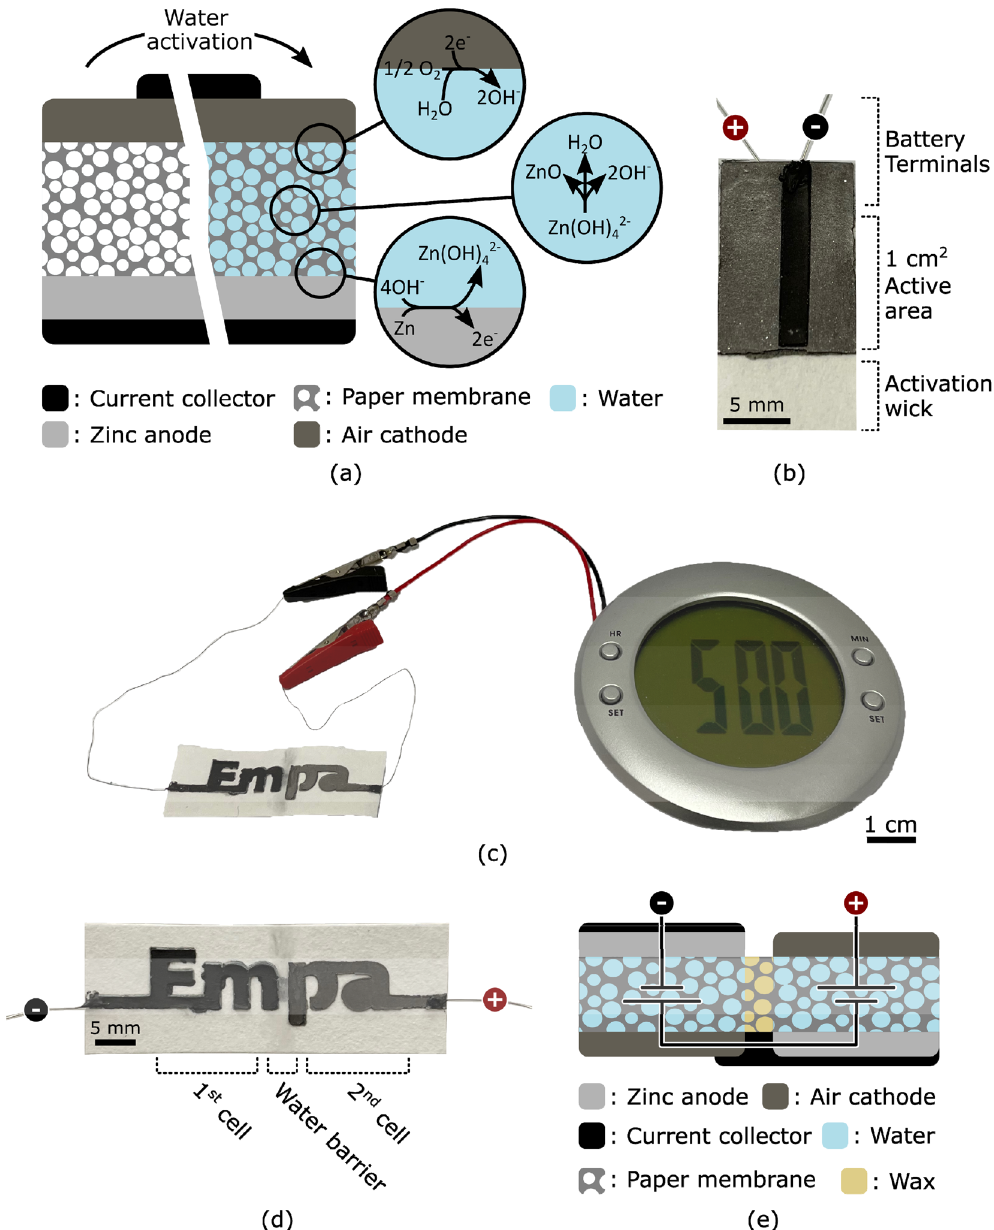
Figure 1. ( a ) Illustration of the water-activated paper battery. Its electrochemical (EC) cell is composed of a paper membrane sandwiched between a zinc-based cathode and a graphite-based air cathode. Carbon-based current collectors are used to extract charges from the EC cell and contact with external circuitry. The device remains inactive until water, which serves as the electrolyte, is provided to the system and permeates the paper membrane. ( b ) Picture of single cell battery fabricated by stencil printing on filter paper. The device is activated by immersing the wick in water or any aqueous solution. At the battery terminals, the filter paper is impregnated with wax to avoid electrochemical reactions of the lead wires and to provide mechanical stability. ( c ) Photograph of a stencil-printed paper battery with a design that spells the name of our research institution (Empa). The battery can run low-power electronics like the liquid crystal display (LCD) alarm clock shown in this photograph. The device is composed of two electrochemical cells that are separated by a water barrier as depicted in the ( d ) photograph, and connected in series as illustrated in the ( e ) schematic cross-section of the battery with its overlaid equivalent circuit (for ideal voltage